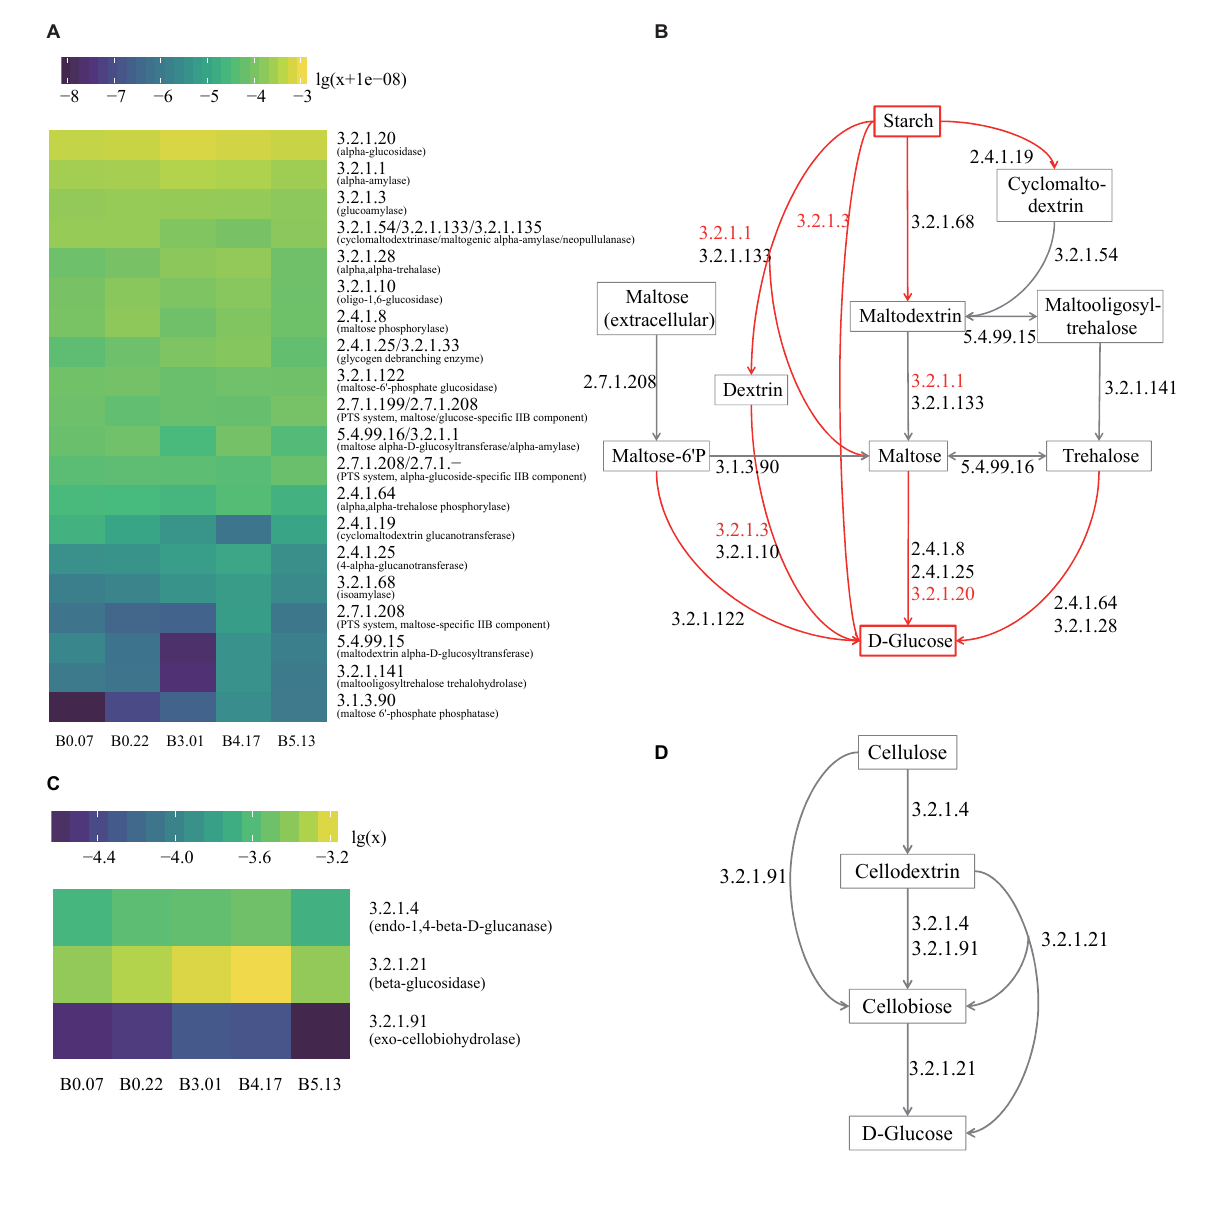
FIGURE 5 | The functional analysis of five mature samples based on metagenome annotation. (A) The heatmap of all genes annotated to the enzymes in the hydrolysis of starch to glucose. The values are decimal abundances transformed with the formula log 10 (relative abundance + 1e-08) (the sum of relative abundances of total genes including other enzymes equals to 1). The labels of Y axis are the EC numbers and enzyme names within parentheses. (B) The hydrolysis pathway of starch to glucose. The red arrows are the actual process of liquefaction and saccharification, which are the hydrolysis of the starch and the production of the glucose. The EC numbers in red refer to the top three enzymes with high gene abundance. (C) The heatmap of all genes annotated to the enzymes in cellulose hydrolysis. The values are decimal abundances transformed with the formula log 10 (relative abundance). (D) The hydrolysis pathway of cellulose to glucose, which is the process in CA